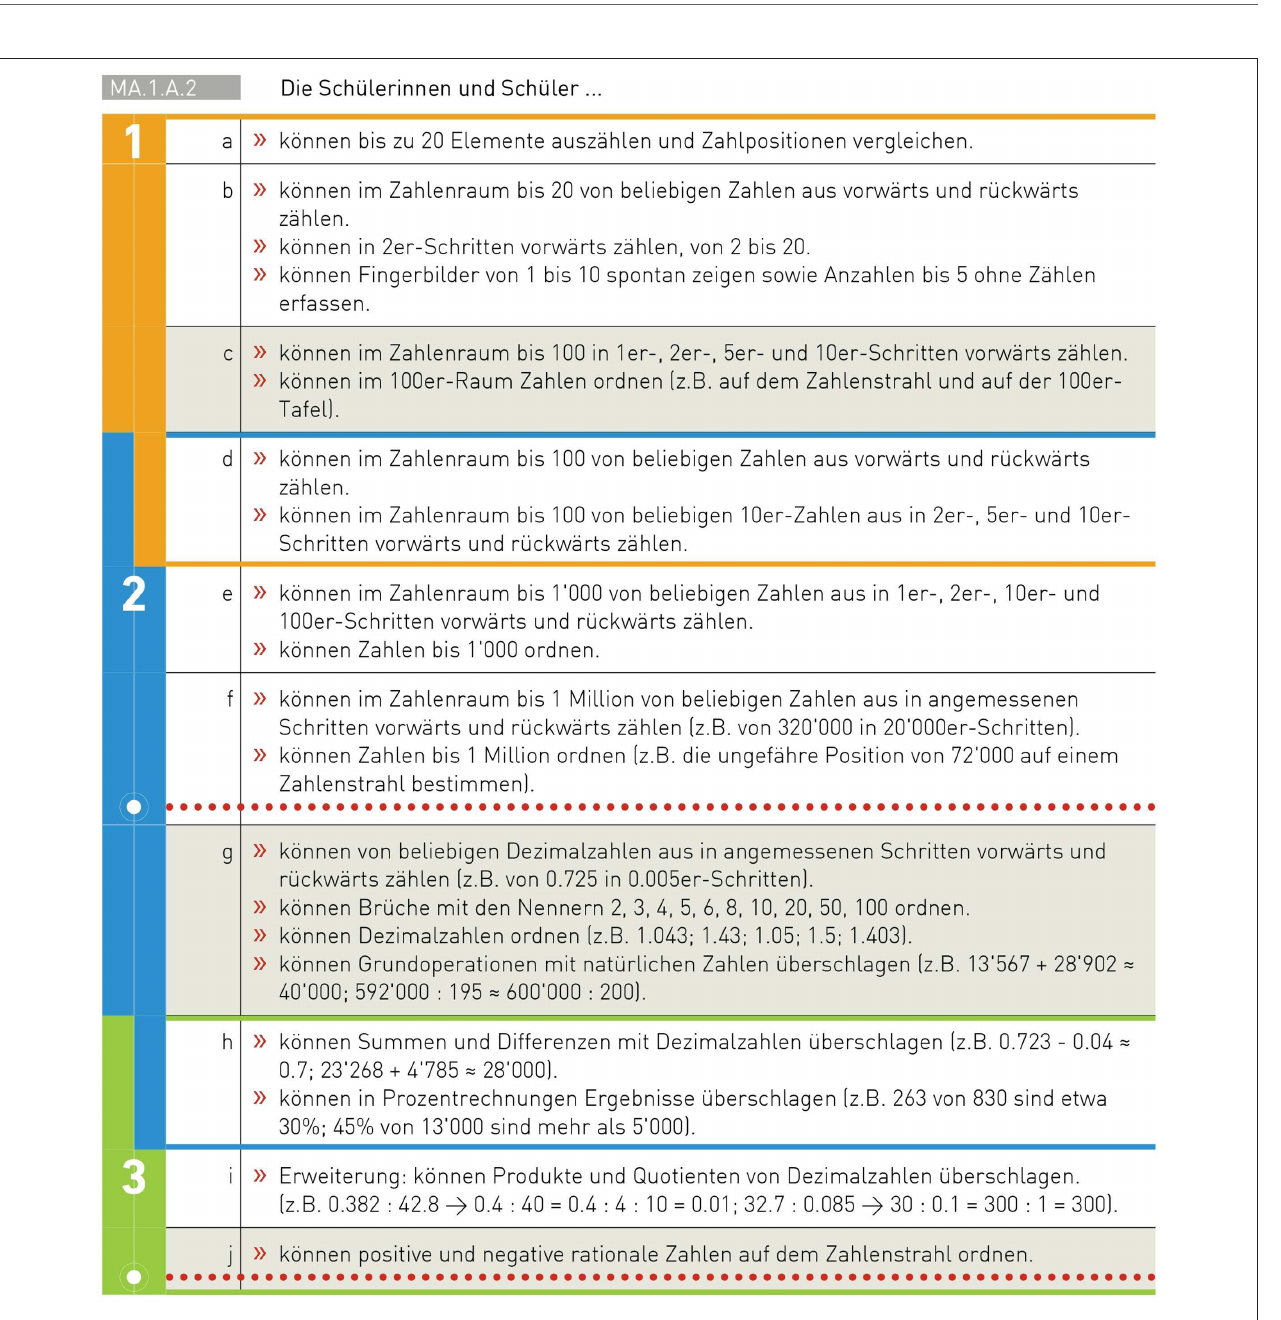
FIGURE 1 | Extract from the curriculum Lehrplan 21 : Example of a mathematics competency and a description of its competence levels. Orange, blue, and green frames indicate the curriculum’s three cycles: cycle 1 = kindergarten through second grade; cycle 2 = third through sixth grades; cycle 3 = seventh through ninth grades. Gray levels refer to the basic requirements within a cycle, and red, dotted lines serve as orientations at the ends of fourth and eighth grades. From D-EDK (2016a) Copyright 2016 by Deutschschweizer Erziehungsdirektoren-Konferenz. Reprinted with permission.